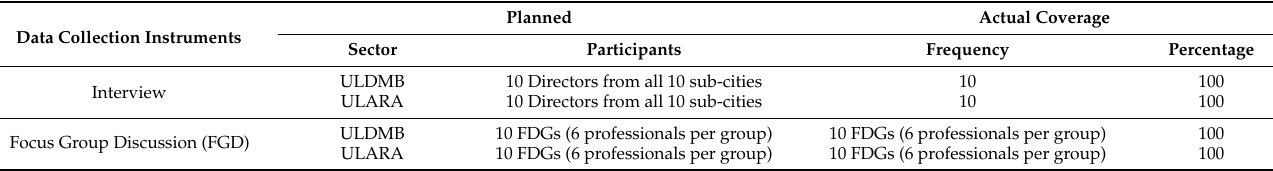
Table 1. Summary of Planned and Actual data collected through Interview and Focus Group Discussion.